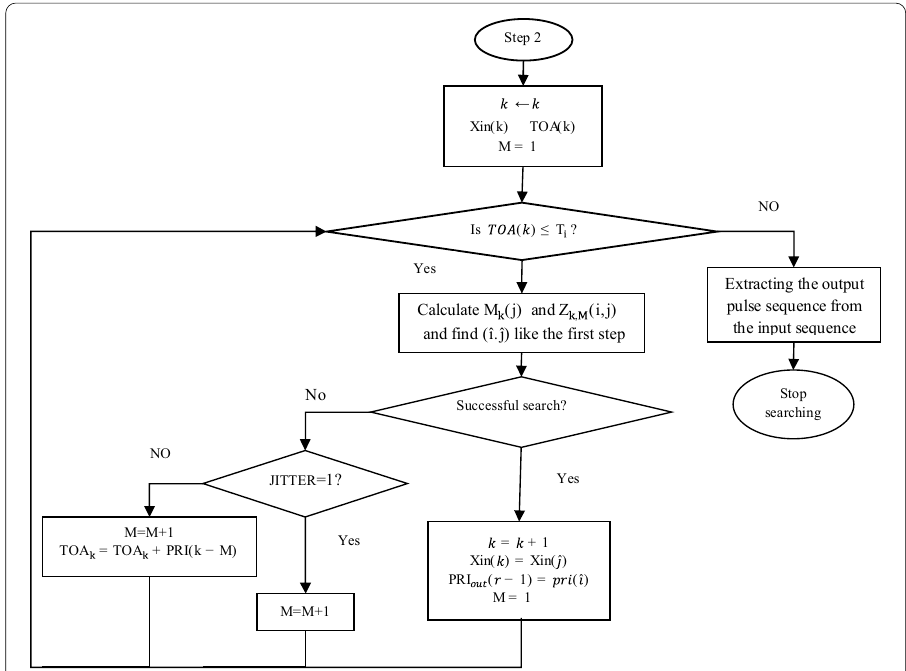
Fig. 5 Second step of the proposed sequence search